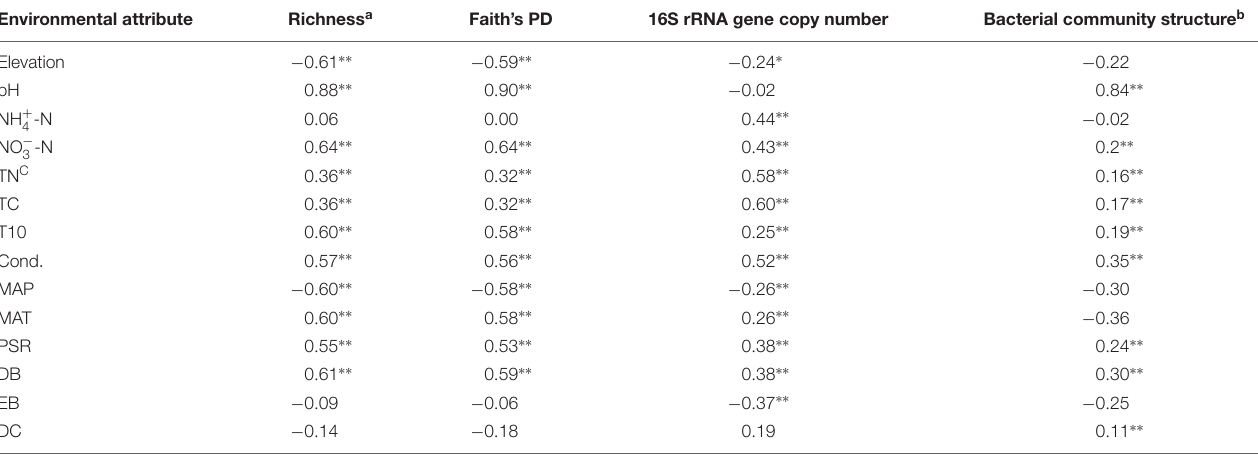
TABLE 1 | Spearman rank correlation analysis and Mantel test showing the relationships of bacterial α -diversity, the 16S rRNA gene copy number, and bacterial community structure with environmental attributes. Environmental